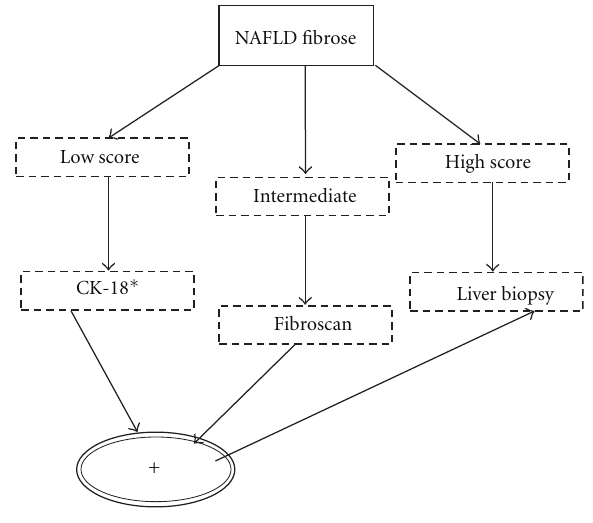
Figure 2: Possible algorithm for the diagnosis of NAFLD. Limits : fibroscan is possible in BMI < 30 kg/m 2 . Adapted by Musso et al.